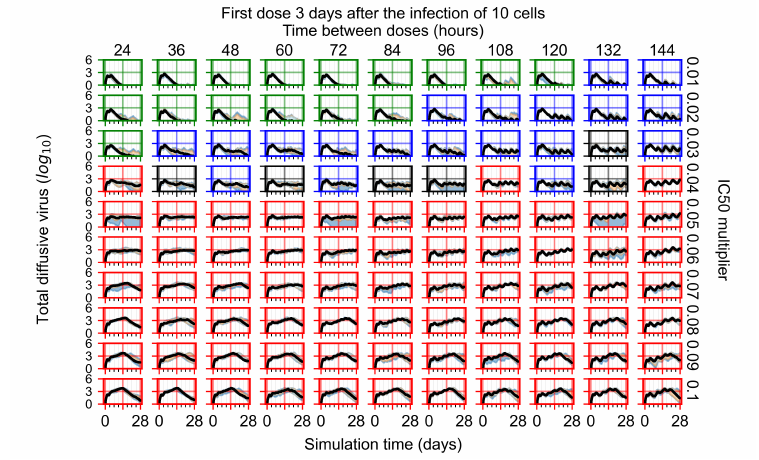
Figure A104. Extracellular diffusive virus quantities (arbitrary units), Y axis in log scale, and exponent values as tick marks.